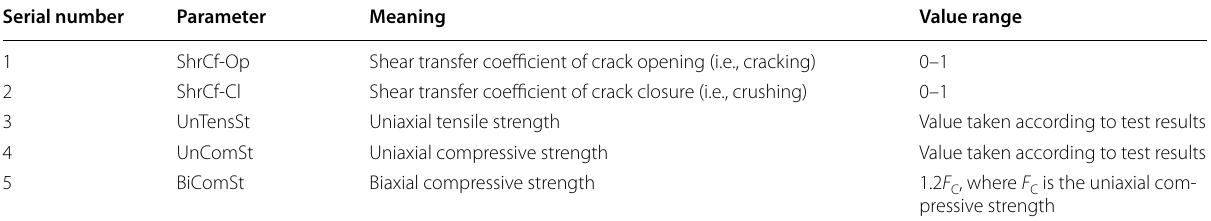
Table 4 William and Warnke failure criterion parameters for concrete.